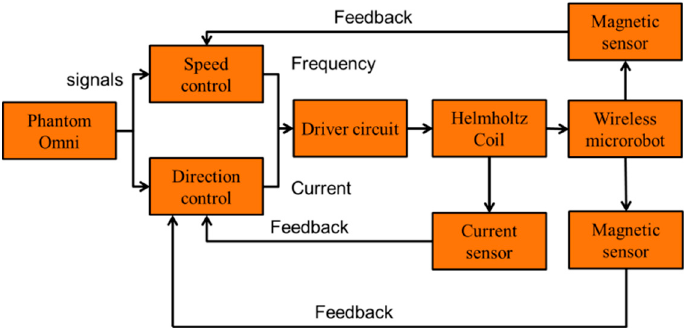
Figure 2. Algorithm design of the magnetically actuated capsule microrobotic system.